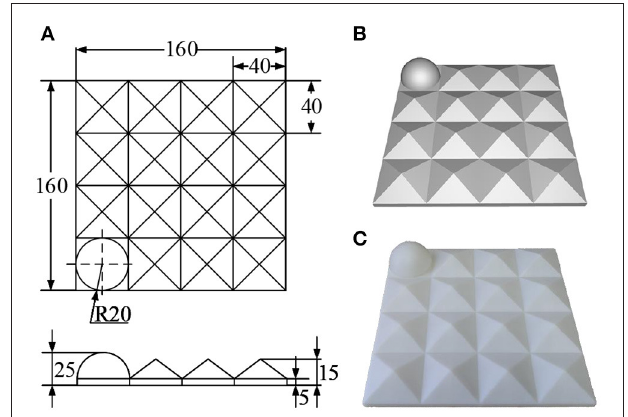
FIGURE 4 | Designed 3D calibration benchmark: (A) engineering drawing (mm); (B) rendering drawing; and (C) physical